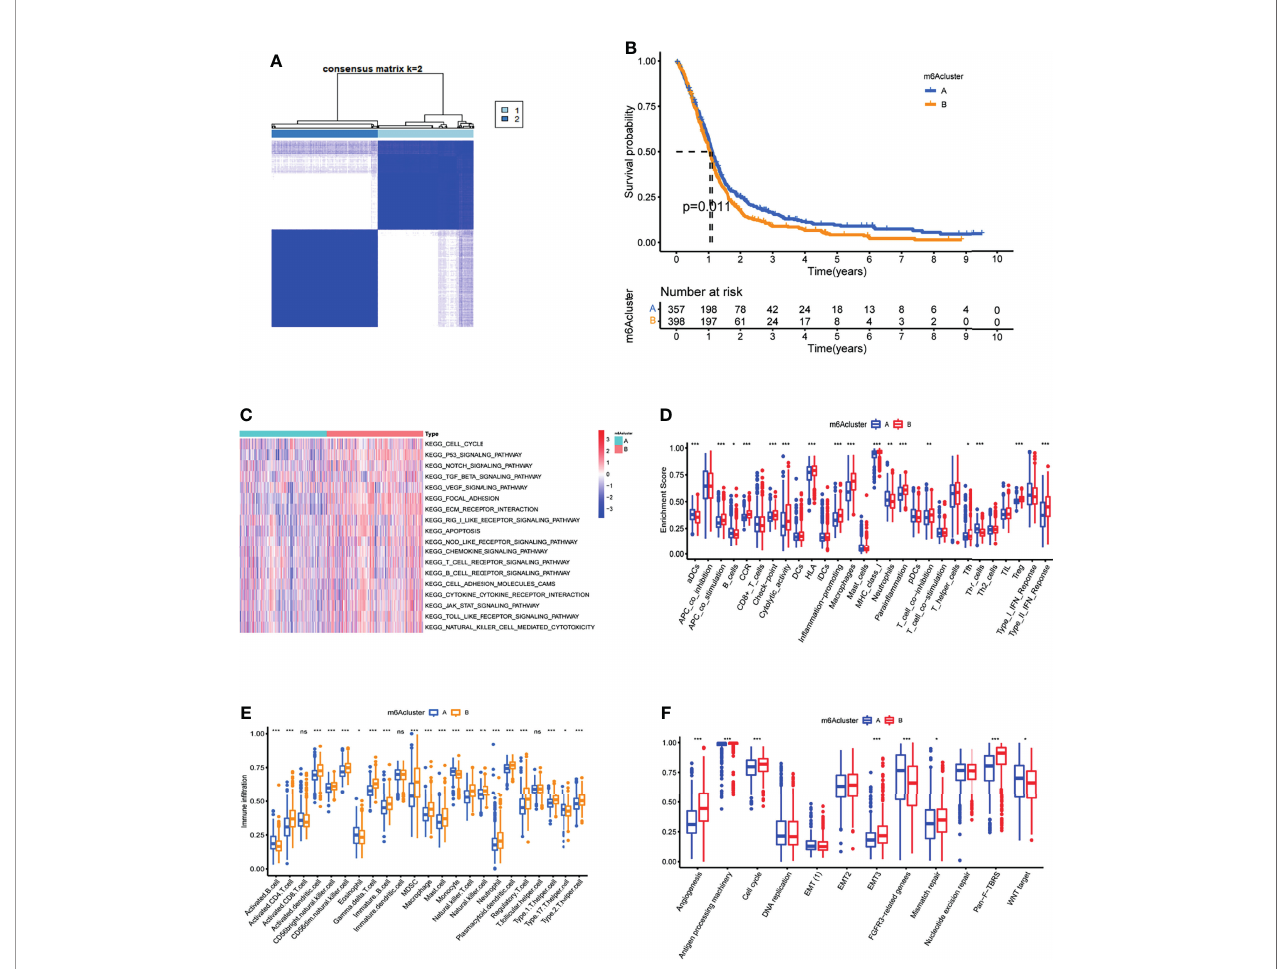
FIGURE 3 | Characterization of the tumor microenvironment in the two m6A methylation patterns. (A) Unsupervised clustering analysis in GBM meta cohort. (B) Kaplan-Meier OS analysis in the two m6A clusters. P = 0.011. (C) GSVA enrichment analysis in the two m6A clusters. Red indicates pathway activation. Blue indicates pathway inhibition. (D) Differential of immune function between the two m6A clusters. (E) Abundance of Immune cell abundance in the two m6A clusters. (F) Enrichment score of common stromal activation pathways in the two m6A clusters.*, **, and *** indicate p = < 0.05, < 0.01, and < 0.001, respectively. ns, not signi fi cant. Upper and lower ends of the boxes indicate interquartile range. The lines in the boxes represent the median